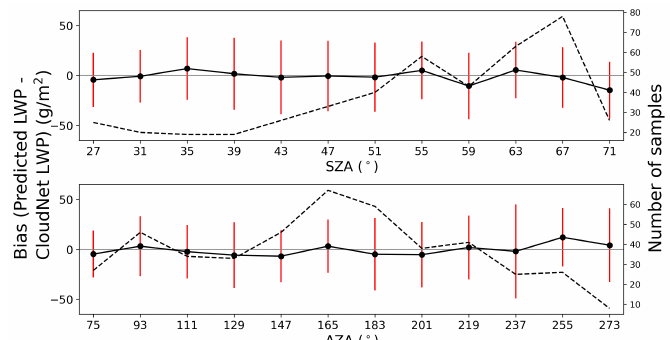
Figure 5. Angle-dependent error plots as a function of solar zenith angle ( top ) and azimuth angle ( bottom ) for test data for homogeneous without feature selection in Leipzig. The black lines are means of the bias between LWP retrieved by the GBRT model and CloudNet LWP with one standard deviation as the red vertical line. The black dashed lines indicate the number of samples.